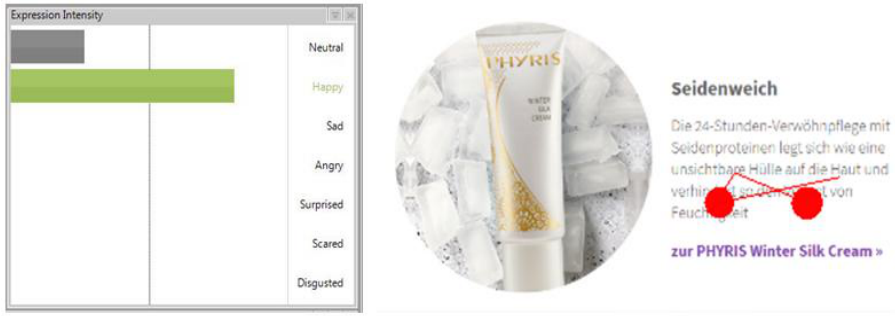
Figure 7. Emotional reaction when reading the textual description after finding the right product [34]